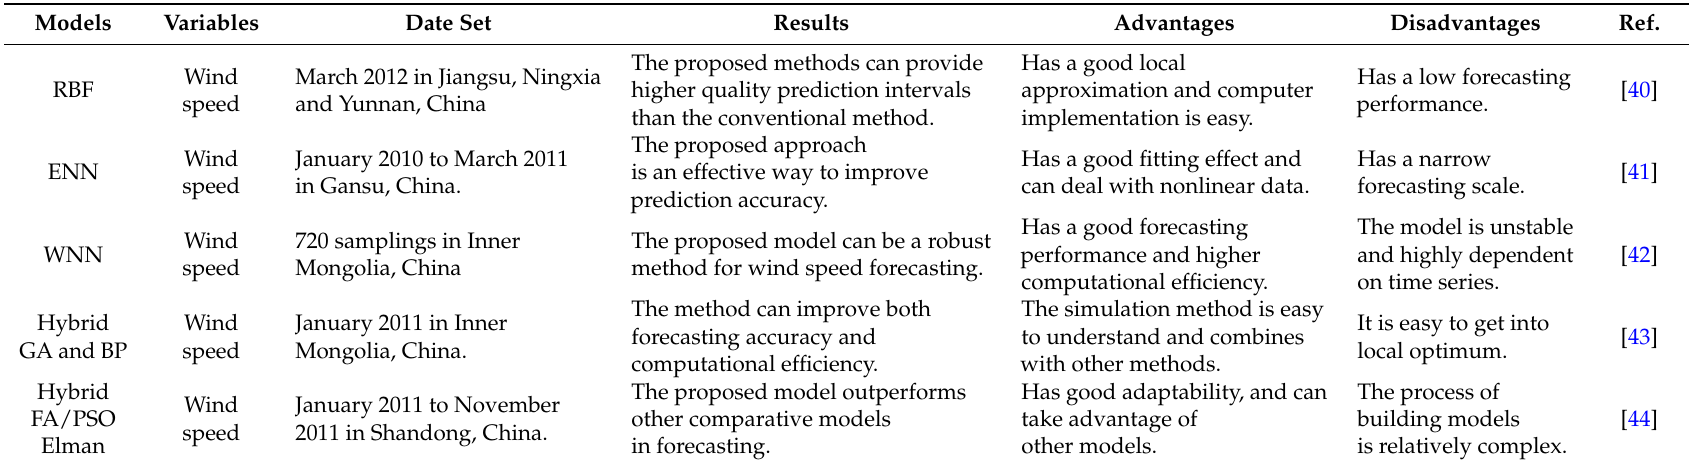
Table 1. Summary of intelligent and hybrid forecasting methods and theoretical comparison of existing forecasting models. RBF: radial basis function; ENN: Elman neural network; WNN: Wavelet neural network; GA: genetic algorithm; BP: back propagation; FA: firefly algorithm; PSO: particle swarm